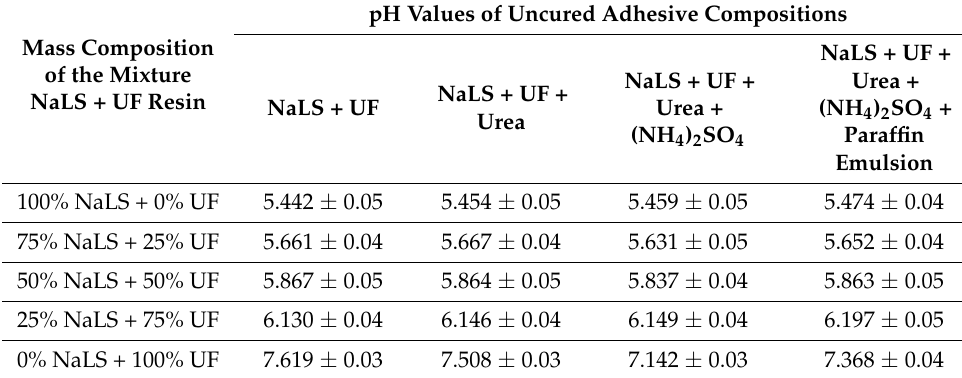
Table 4. pH values of freshly prepared uncured adhesive compositions of NaLS.